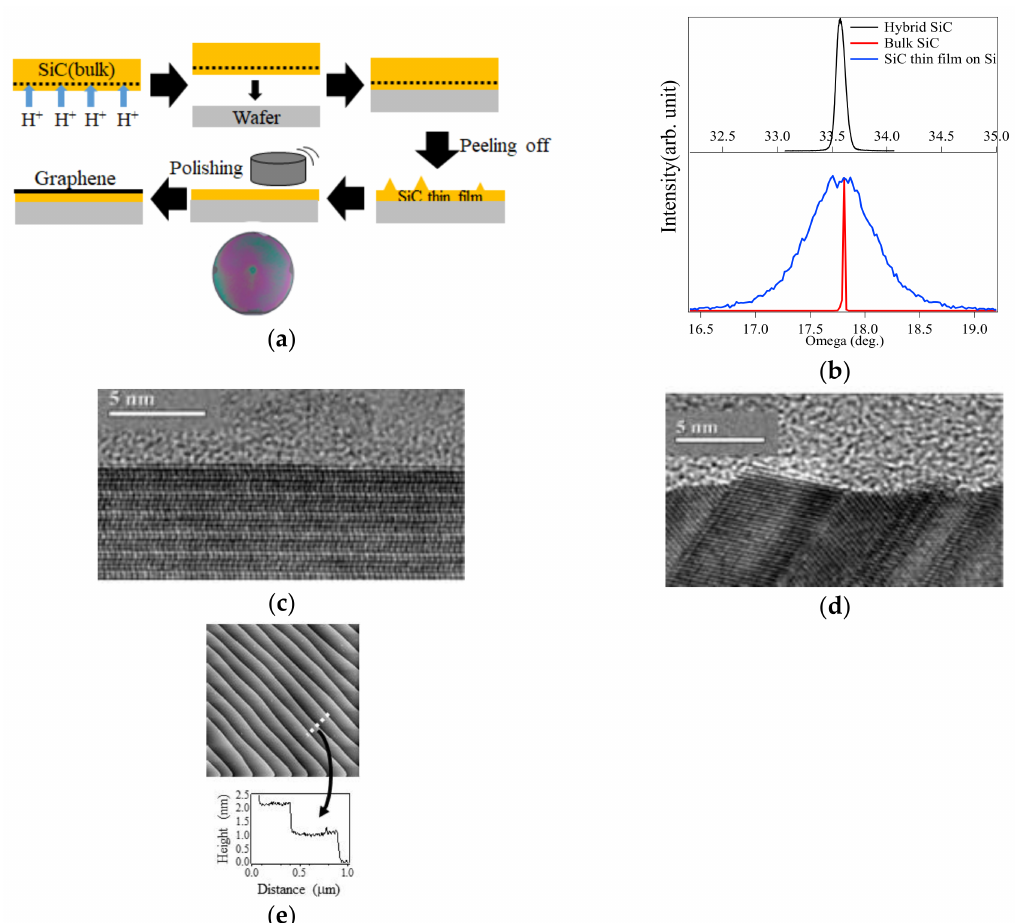
Figure 1. ( a ) Schematics of the fabrication of the hybrid SiC. ( b ) The x-ray diffraction of the hybrid SiC, a 3C-SiC thin film on a Si substrate. ( c , d ) are cross-sectional transmission electron micrographs of the hybrid SiC surface and the 3C-SiC thin film on the Si substrate, respectively. ( e ) The atomic force microscopy image of the hybrid surface. Inset shows the line profile across the dotted